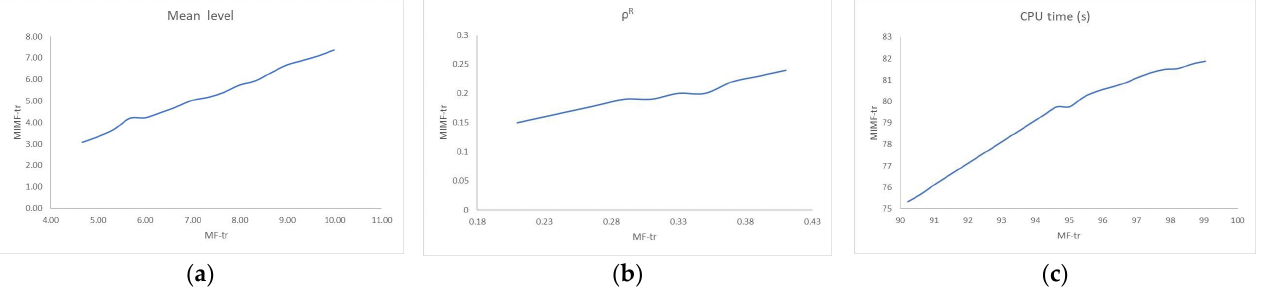
Figure 7. Trend of: ( a ) Mean level; ( b ) final compressed rate; ( c ) CPU